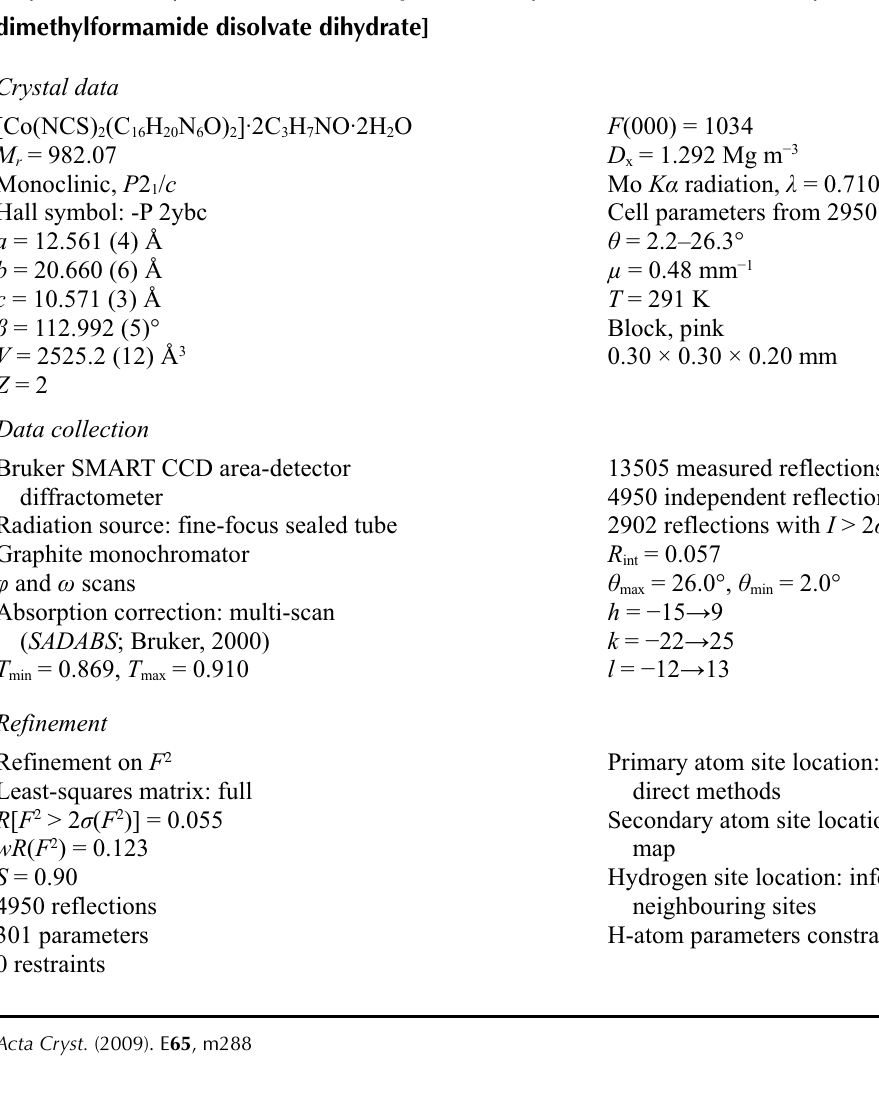
Figure 1 A portion of the crystal structure of the title compound, showing 30% probability displacement ellipsoids and the atom- numbering [symmetry codes: (A) - x + 1, - y + 1, - z + 1; (B) - x + 1, y - 1/2, - z + 3/2; (C) x , - y + 3/2, z - 1/2]. Poly[[[diisothiocyanatocobalt(II)]-bis[ µ -4- tert -butyl-